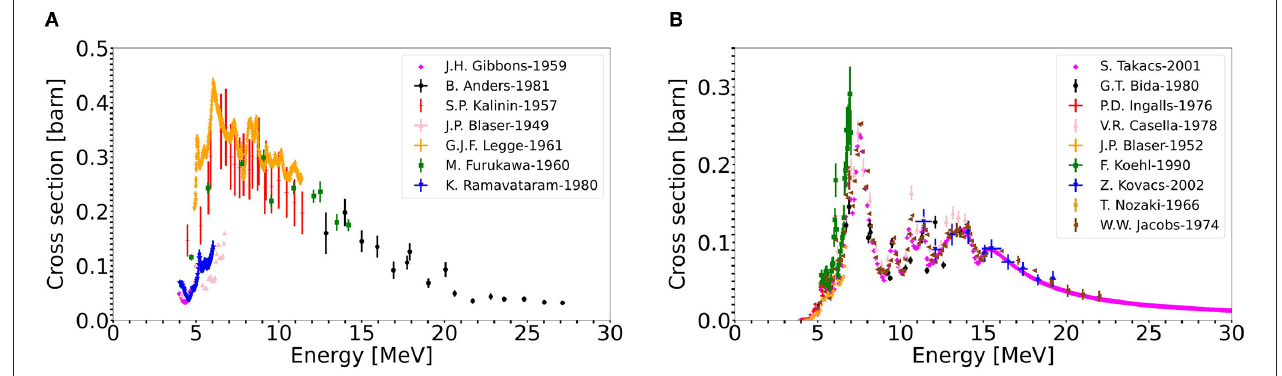
FIGURE 4 | 11 C production cross sections from the proton induced reactions (A) 11 B(p,n) 11 C, (B) 14 N(p, α ) 11 C